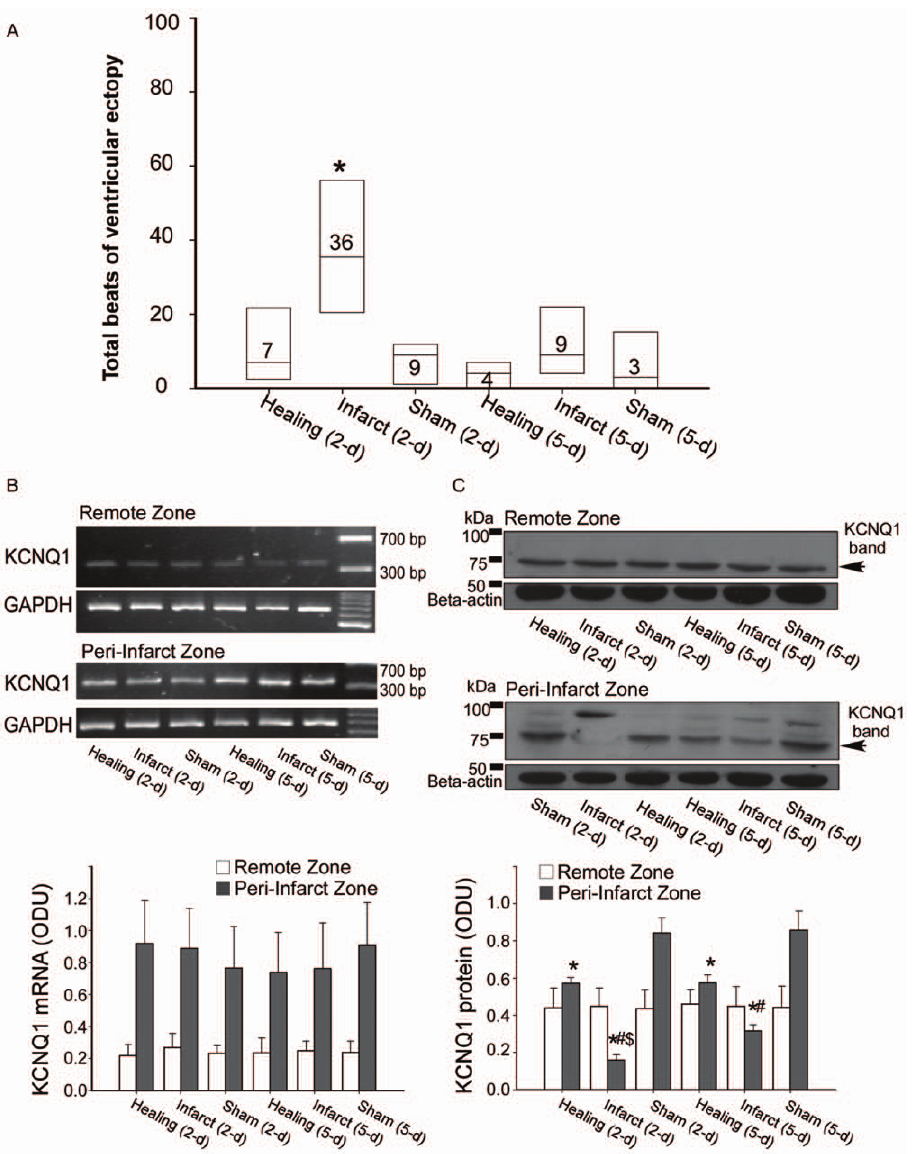
Figure 5. Comparison of ventricular premature beats and KCNQ1 expression between groups. ( A ) Comparison of the total premature ventricular beats (PVBs) between the groups within 10 min after bolus injection of epinephrine. Results are presented in a box plot format (n=6–8) where boxes indicate the 25–75% interval along with the median of the data. * P , 0.05 vs. the other groups. ( B ) Reverse transcription-polymerase chain reaction (RT-PCR) of KCNQ1 mRNA levels. Top: Examples of KCNQ1 mRNA with samples harvested from the peri-infarct zone and remote zone of the Healing (2-d; n=6), Infarct (2-d; n=8), Sham (2-d; n=7), Healing (5-d; n=7), Infarct (5-d; n=7), and Sham (5-d; n=8) groups of rabbit hearts. Bottom: mean KCNQ1 mRNA band intensities. ( C ) Western blot analysis of membrane-associated KCNQ1 protein levels. Top: Representative immunoblot results showing membrane KCNQ1 protein ( , 75 kDa) with samples harvested from the peri-infarct zone and remote zone of the six groups of rabbit hearts. Bottom: mean membrane KCNQ1 protein band intensities. * P , 0.05 vs. Sham (2-d) and Sham (5-d) respectively; # P , 0.05 vs. Healing (2-d) and Healing (5-d) respectively; $ P , 0.05 vs. Infarct (5-d).